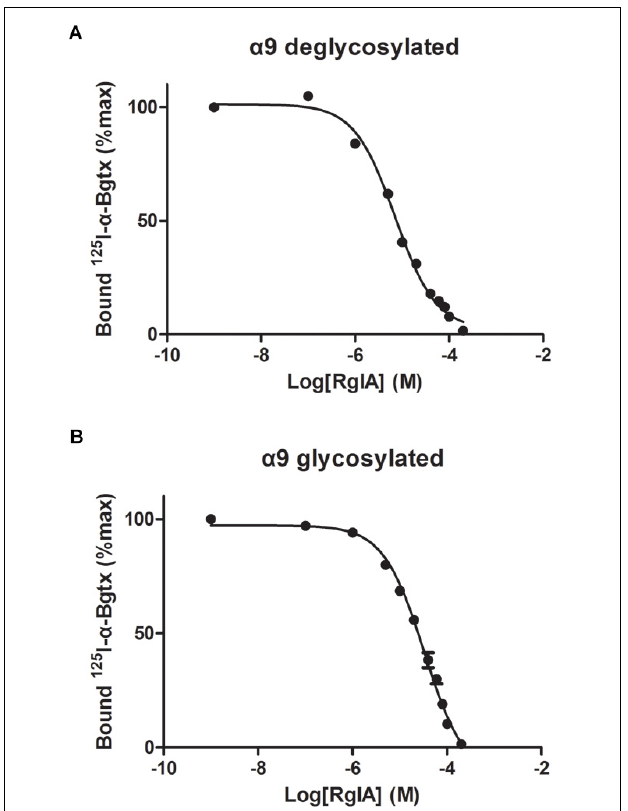
FIGURE 3 | Competition of radiolabeled α -Bgtx by RgIA. (A) On deglycosylated α 9-ECD (B) On glycosylated α 9-ECD. Each graph is from four experiments and standard errors are presented with